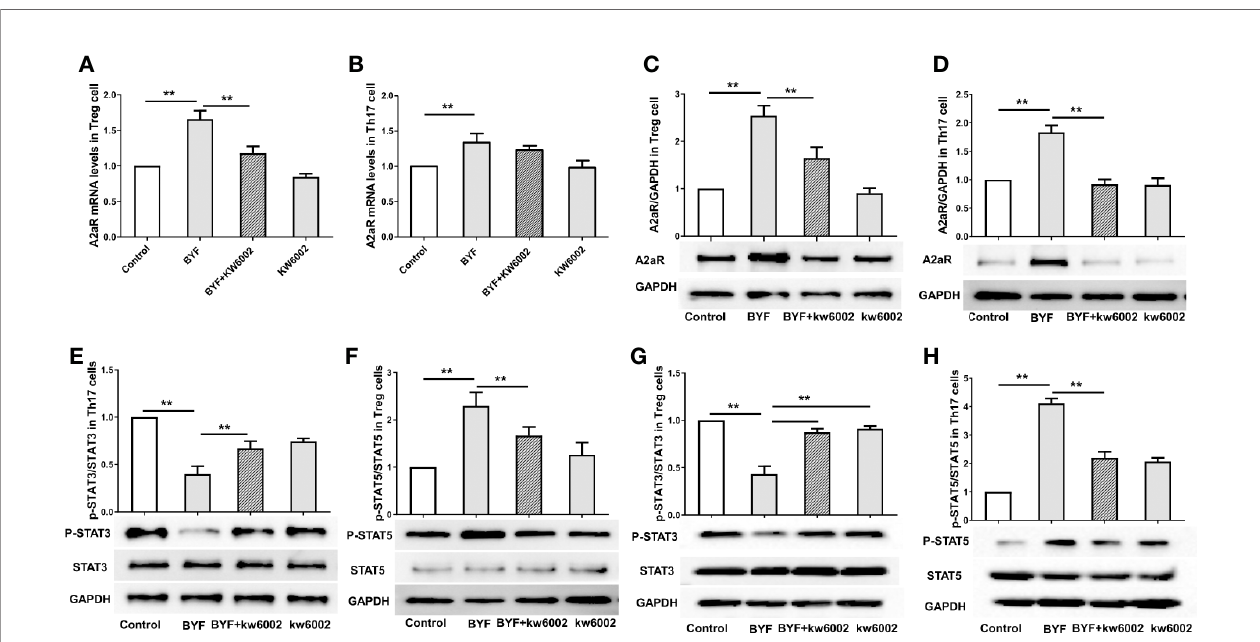
FIGURE 3 | Effect of Bufei Yishen formula (BYF) on A2aR and STAT3/5 in Th17 and Treg cells. Naïve CD4+ T cells were treated with Th17 differentiation conditions or Treg differentiation conditions in the presence or absence of BYF (60 m g/ml) or KW6002 (0.1 m M) for 3 days. The mRNA levels of A2aR in Treg (A) and Th17 cells (B) ; the protein levels of A2aR in Treg (C) and Th17 cells (D) ; the protein levels of STAT3 and p-STAT3 in Th17 cells (E) and Treg cells (G) and STAT5 and p-STAT5 in Treg cells (F) and Th17 cells (H) . **P <